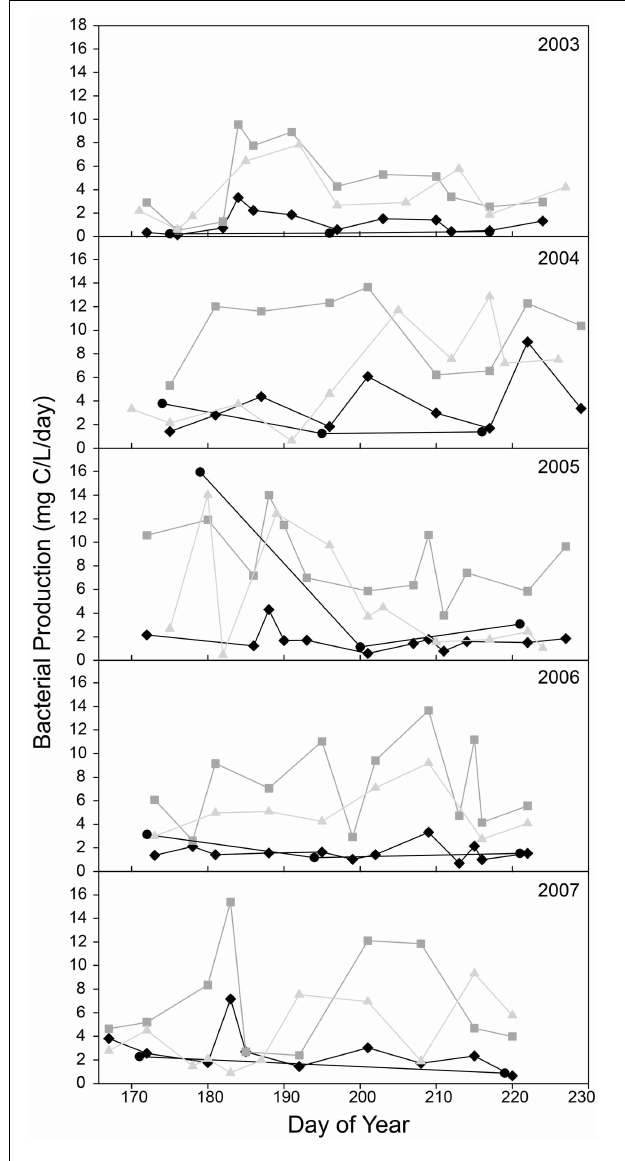
FIGURE 2 | Bacterial Production at sites upstream and downstream of Lake I-8 for sites I-8 headwaters (black circles), I-8 inlet (black diamonds), I-8 outlet (gray squares), and I-8 to I-9 (gray triangles).